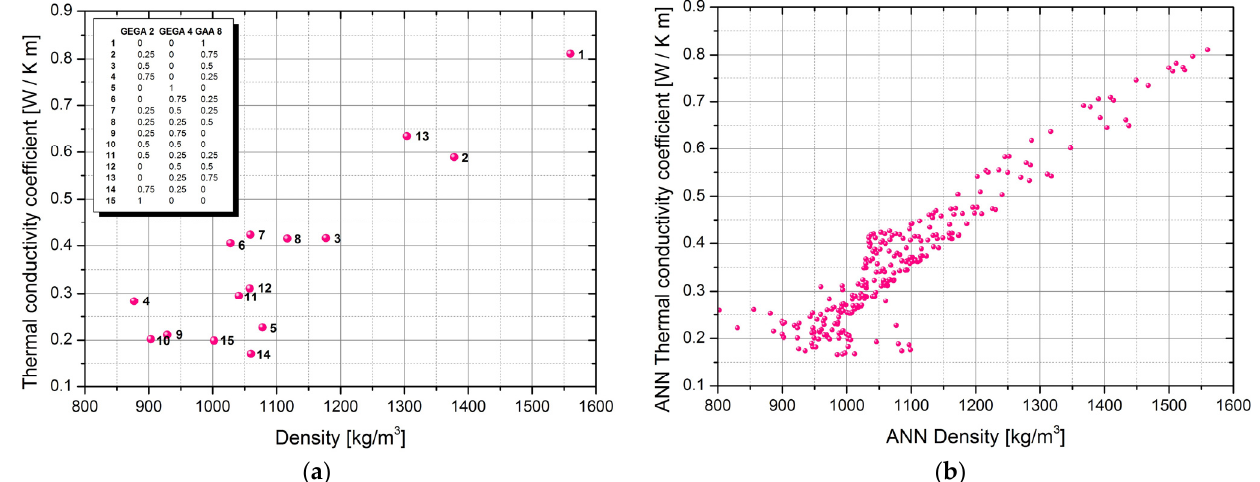
Figure 7. Graphical presentation of the relationship between the thermal conductivity coefficient and density of the LWC based on: ( a ) laboratory test results; ( b ) ANN prediction.